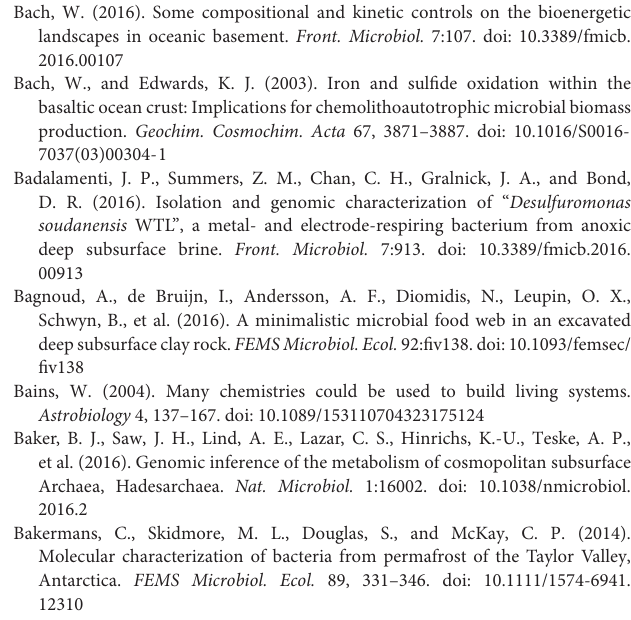
TABLE S1 | Environmental values and equations used to calculate Gibbs free energy and energy density calculations. TABLE S2 | Source references for values in Supplementary Table S1